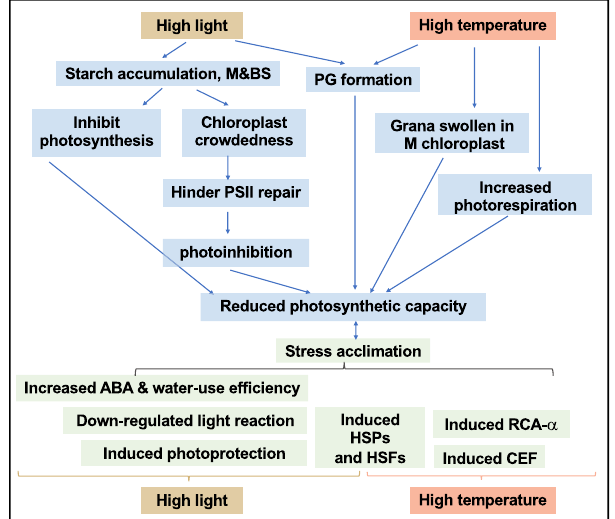
Fig. 10 Summary of how S. viridis responds to high light or high temperature. Light blue boxes denote changes that may lead to the reduced photosynthetic capacities; light green boxes denote changes that may be adaptive for high light or high temperature acclimation. M: mesophyll chloroplasts; BS, bundle sheath chloroplasts. High-light-treated leaves had over-accumulated starch and increased chloroplast crowdedness, which may hinder PSII repair and result in photoinhibition. Starch accumulation may also inhibit photosynthesis through feedback regulation. Increased plastoglobuli (PG) formation in high-light-treated leaves may affect thylakoid composition and function. Under high temperature, mesophyll chloroplasts had swollen grana and bundle sheath chloroplasts had some different responses. Heat-induced photorespiration and PG formation could further reduce photosynthesis. Meanwhile, high light and high temperature also induce adaptive responses for acclimation. Under high light, the induced photoprotection, down-regulated light reaction, and increased water-use ef fi ciency through abscisic acid (ABA) can help S. viridis acclimate to excess light. Under high temperature, the induced cyclic electron fl ow (CEF) and Rubisco activase (RCA- α ) can protect photosynthesis from heat stress. The induced heat shock transcription factors (HSFs) and heat shock proteins (HSPs) are adaptive responses to both high light and high temperature, although the induction was much quicker under high temperature than under high